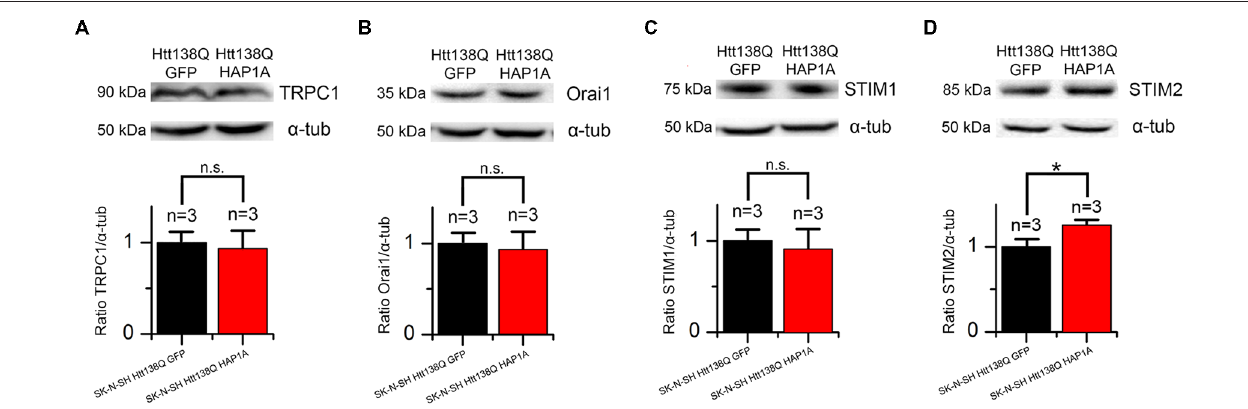
FIGURE 10 | Expression levels of proteins that are involved in SOCE in SK-N-SH Htt138Q HAP1A. (A–D) Expression levels of transient receptor potential channel type 1 (TRPC1) (A) , Orai1 (B) , STIM1 (C) and STIM2 (D) proteins (normalized to α -tubulin) in SK-N-SH Htt138Q cotransfected with GFP (black bars) or HAP1A (red bars). On the top of each panel, the representative Western blots are shown. On the bottom of each panel, the expression levels of proteins are plotted as mean ± SEM. ∗ p < 0.05, significant difference in expression level. ns, not significant. The number of tested lysates is shown above the